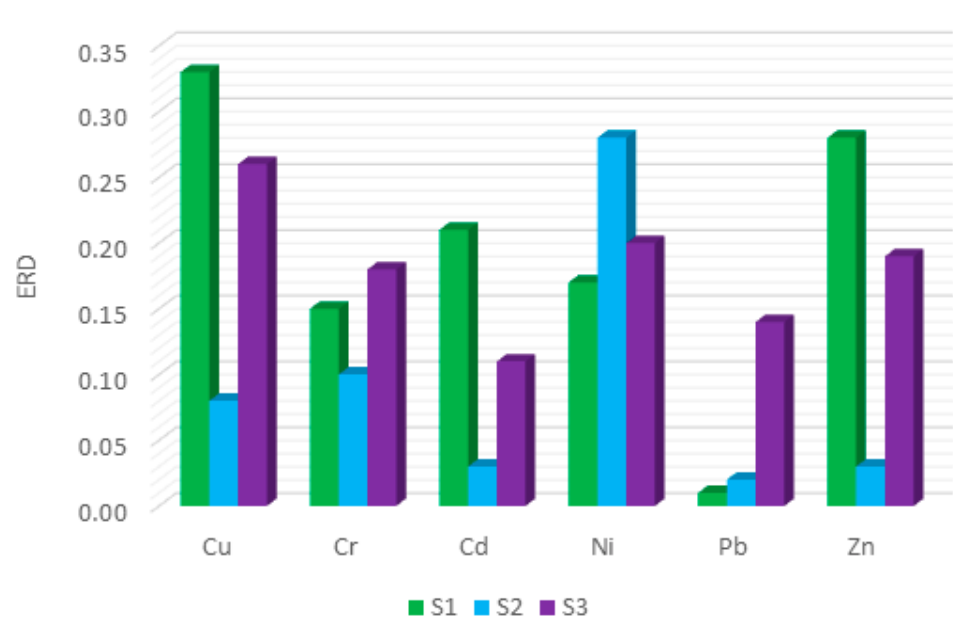
Figure 5. The environmental risk factor (ERF) of HMs in SS.